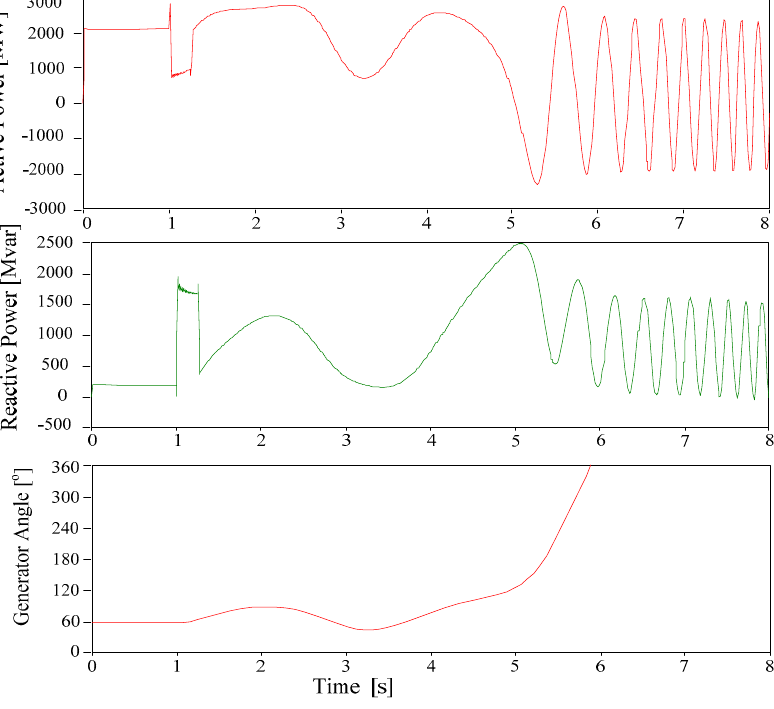
Figure 14. The time variation of generator angle δ and reactive power Q after the inception of the fault.